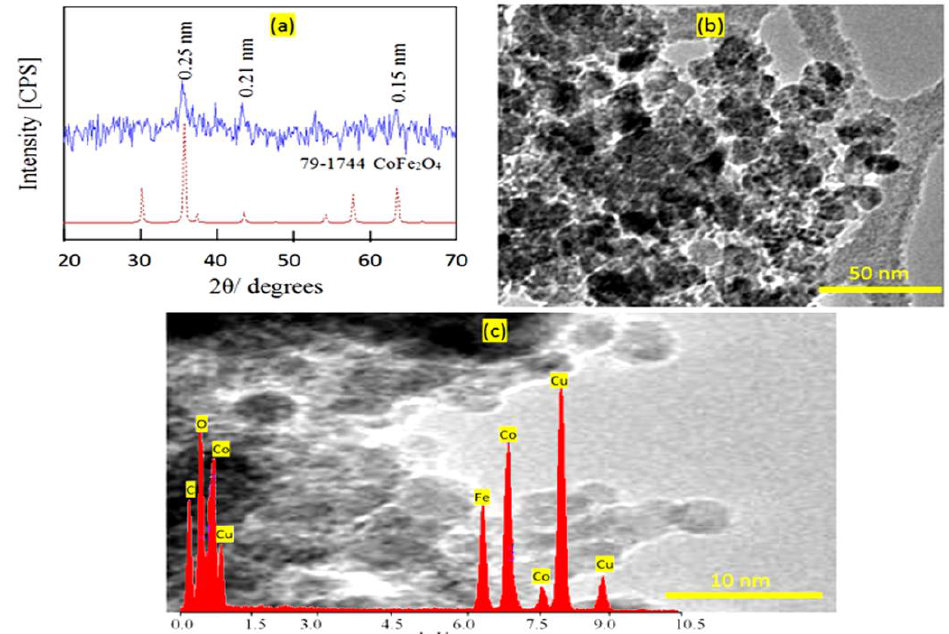
Figure 2. The prepared cobalt iron oxides nanocomposite ( a ) X-ray diffraction pattern, ( b ) TEM image at 50 nm, and ( c ) TEM image at 10 nm (inset: EDX spectrum).